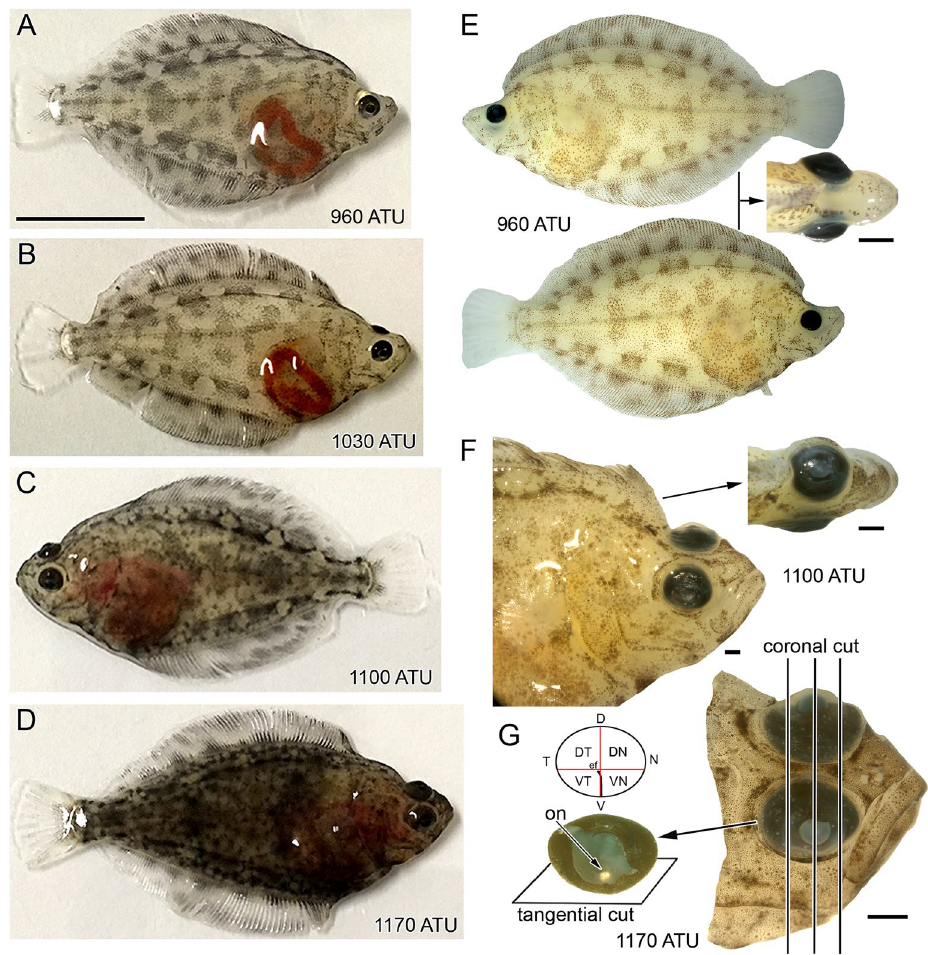
Figure 1. Developmental stages of Atlantic halibut examined illustrating eye migration and orientation of histological sectioning. ( A – D ) Body morphology of live fish at approximately 960 ATU (82 days post-hatching) ( A ), 1030 ATU (89 days post-hatching) ( B ), 1100 ATU (96 days post-hatching) ( C ), and 1170 ATU (103 days post-hatching) ( D ). The left eye is migrating in all fish except for the one shown in ( C ), where the right eye is migrating. ( E ) Lateral and top views of a fixed specimen at 960 ATU. Migration of the left eye has just started. ( F ) Lateral and top views of a fixed specimen at 1100 ATU. The left eye has migrated half way between the blind side (bottom part of the fish following metamorphosis) and ocular side (top part of the fish following metamorphosis). ( G ) Head of fixed specimen at 1170 ATU showing completed eye migration and the extracted right eye without lens. The optic nerve (on) exits the retina below the crossing of theoretical short and long ellipse axes that characterize this elliptically-shaped eye and retina. The optic nerve head coincides with the central end of the embryonic fissure (ef) which extends to the ventral periphery. The panel illustrates the direction of sectioning when full eyes were cut, revealing tangential sections of central retina and more oblique sections toward the periphery, and coronal cuts when a head was sectioned, revealing radial views of the retina throughout the lens region and tangential views at the nasal and temporal ends. The schematic shows the division of a right eye retina into quarters (VT, ventrotemporal; VN, ventronasal; DT, dorsotemporal; DN, dorsonasal). Other abbreviations: V, ventral; D, dorsal; N, nasal; T temporal. Scale bar in (A) equals 1 cm and holds for ( B – D ) and the lateral views in ( E ); the other scale bars represent 1 mm and are associated with the figures closest to